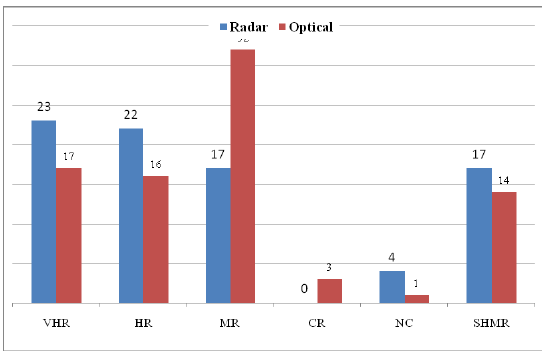
Fig. 2: Diagram of the resolution types